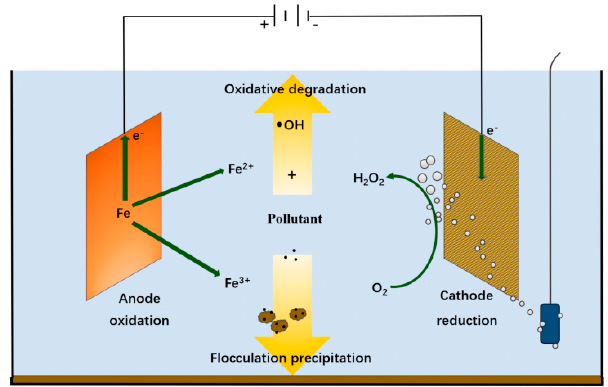
Figure 3. Electro-Fenton reaction mechanism diagram [42].